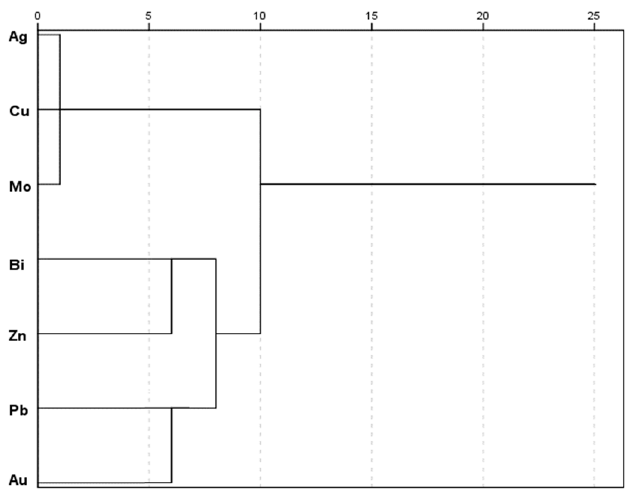
Figure 9. The result of Hierarchical Clustering Analysis (HCA) of data in the form of a dendrogram.